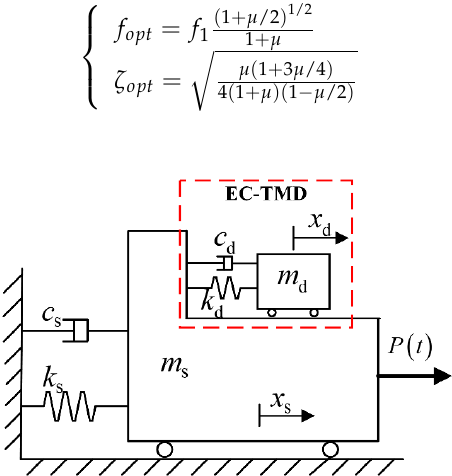
Figure 3. An equivalent two-degree of freedom system.